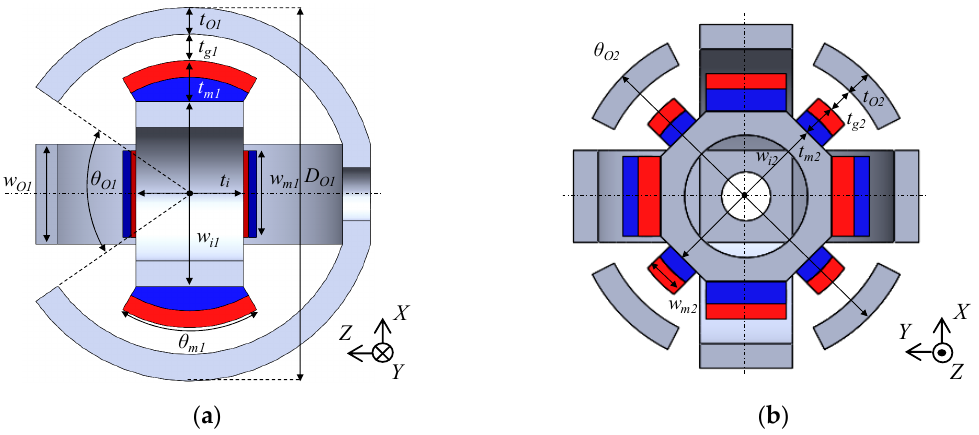
Figure 5. Design parameters of the actuator without the coils. ( a ) X – Z cross section; ( b ) X – Y Figure5. Designparametersoftheactuatorwithoutthecoils. ( a ) X – Z crosssection; ( b ) X – Y crosssection. cross section. Table 1. Dimensions of the Table 1. Dimensions of the actuator.